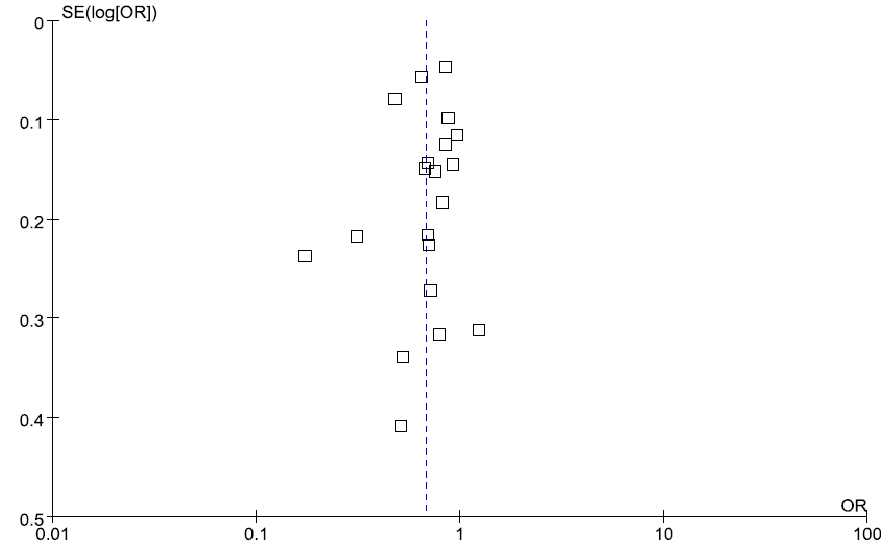
Figure A3. Funnel plots for CHD in the moderate drinking compared with non-drinking category intake of “alcohol consumption” pattern in all studies.